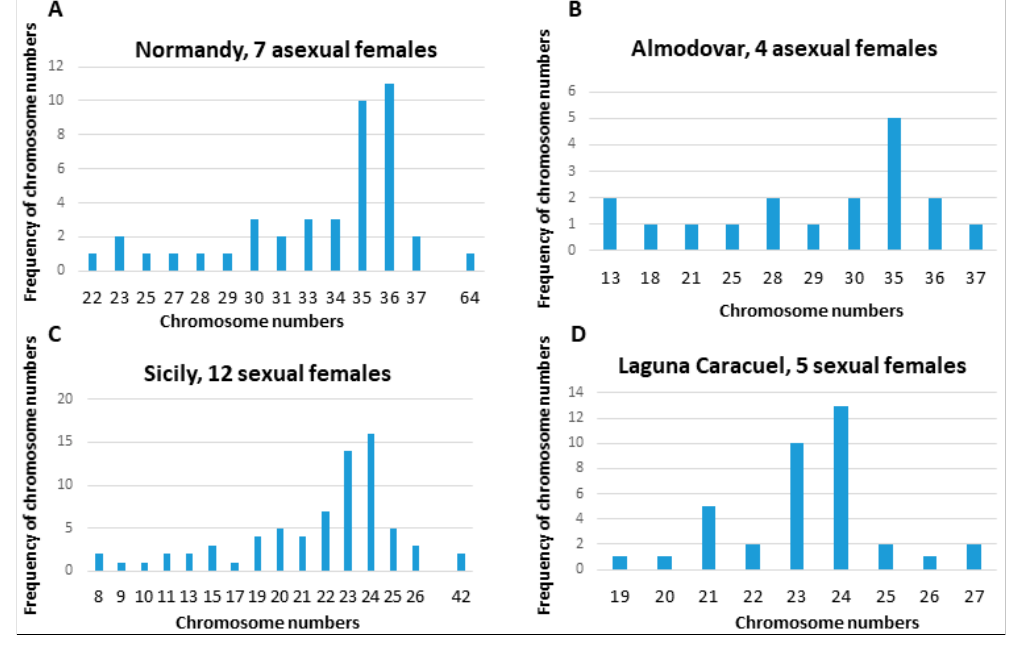
Figure 1. Variation in chromosome numbers in populations of Eucypris virens . ( A ) asexual 3n females from France, n = 7; ( B ) asexual 3n females from Spain, n = 4; ( C ) sexual 2n female from Italy, n = 12; ( D ) sexual 2n females from Spain, n = 5.